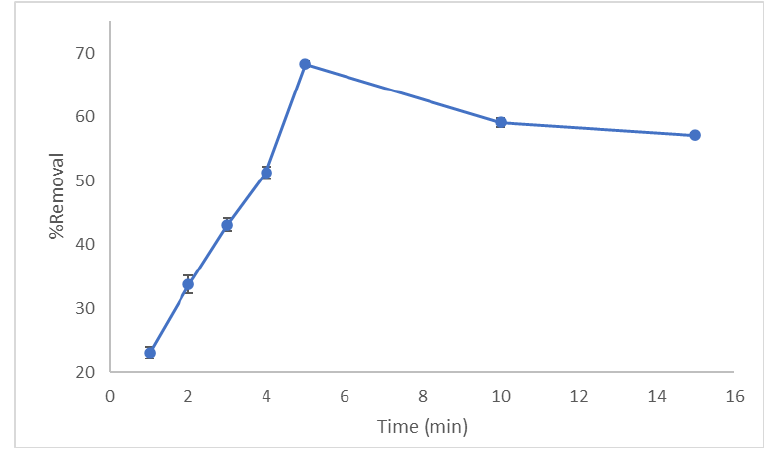
Figure 6. Effect of contact time on % removal of CV using LCF.